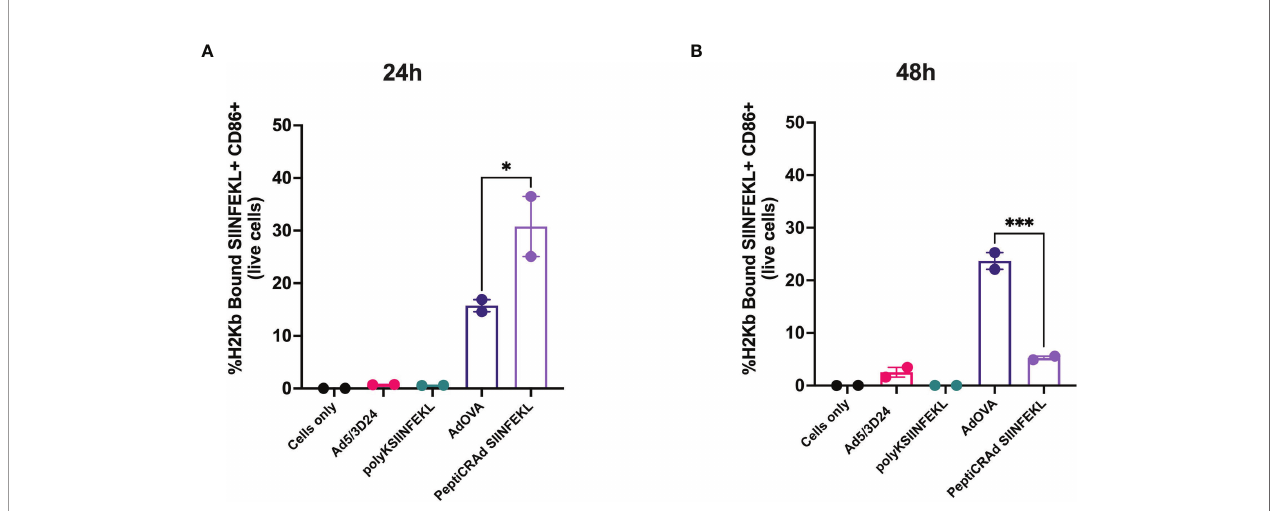
FIGURE 2 | DCs cross-present antigen in an immunogenic fashion upon stimulation with Ad encoding TAs or PeptiCRAd. Mouse dendritic cell line JAWS II was pulsed with Ad5/3 D 24, peptide alone (polyKSIINFEKL), AdOVA, PeptiCRAd-SIINFEKL or left unpulsed (cells only). The viruses were used at 250 MOI. Flow cytometry analysis was used to determine the cross-presentation at 24h (A) and 48h (B) post incubation. CD86 was used to measure DCs activation and an antibody speci fi c for OVA peptide SIINFEKL complexed with H2Kb to detect the antigen presentation. The data are depicted as bar plot mean ± SEM. Statistical analysis was performed with ordinary One-way ANOVA (ns P > 0.05, *P ≤ 0.05, **P ≤ 0.01, ***P ≤ 0.001, P ≤